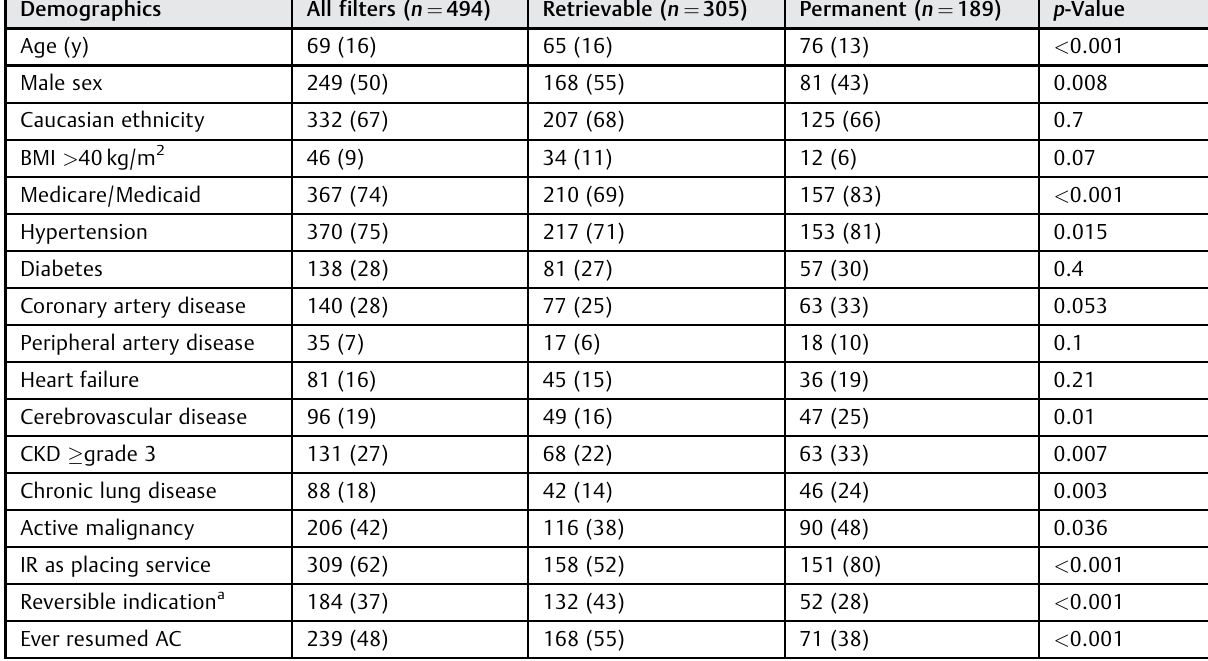
Table 1 Demographics and baseline characteristics of VCF population